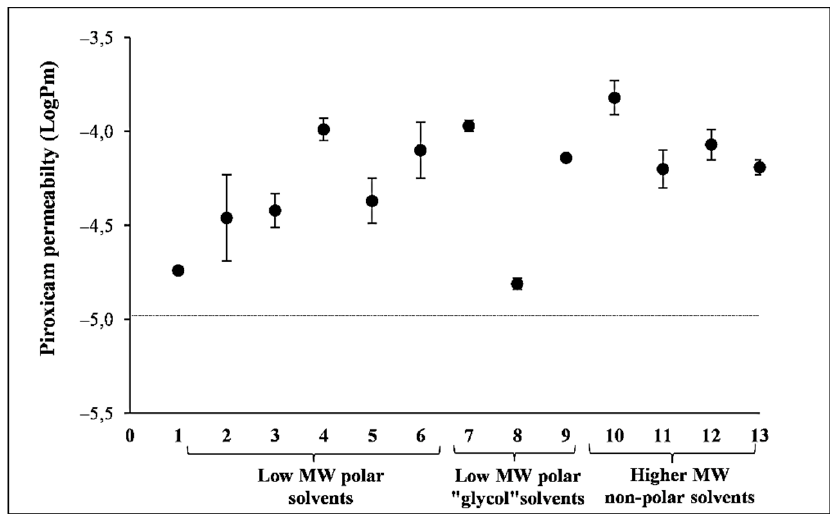
Figure 1. Effect of 13 solvents on the integrity of the Skin-PAMPA membrane using piroxicam as the model permeant. Permeability of piroxicam dissolved in water was measured after 7 h pre-treating membranes with each solvent. The permeability values are mean ± SD, n = 9.